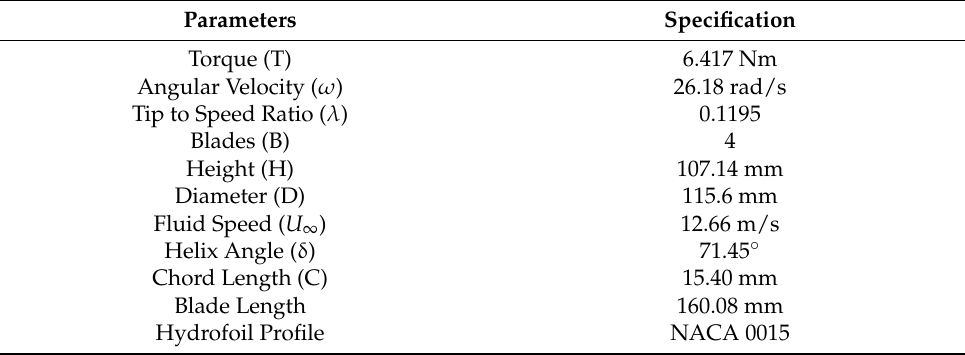
Table 3. Design parameters of the spherical helical